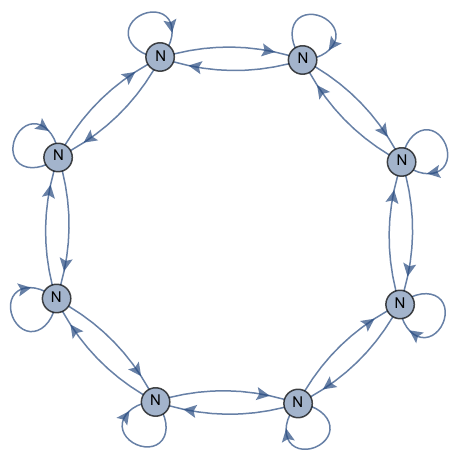
Figure 1 . A n (cid:0) 1 necklace quiver gauge